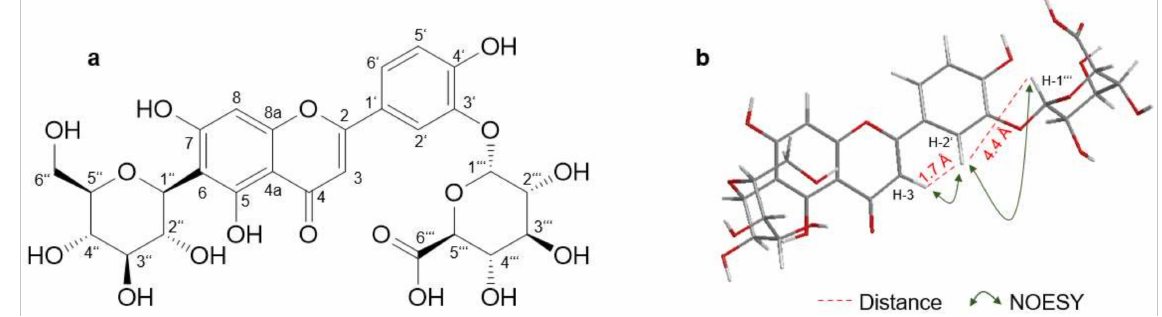
Figure 4. Chemical structure of isoorientin-3 (cid:48) - O - α -glucuronide ( a ) and its key NOESY correlations ( b ). Table 2. 1 H and 13 C NMR data (700 and 175 MHz, respectively; DMSO-d 6 , δ in ppm, J in Hz) for isoorientin